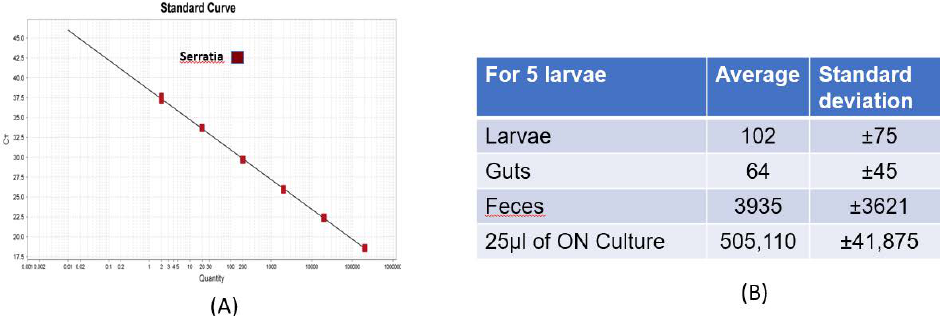
Figure 5. ( A ) The qPCR standard curve, necessary to perform the quantitative analysis, was made with the positive control supplied in the kit. The number of Ct was plotted on the graph. Knowing the number of copies of the positive control, the standard curve was created, and the number of copies of an unknown sample could be plotted. The lower the Ct, the higher the number of bacteria. ( B ) The numbers refer to the quantity of Sm bacteria extrapolated from qPCR analysis on DNA extracted from different Tm samples and the quantity of Sm in an overnight culture used to inoculate wheat bran consumed by Tm